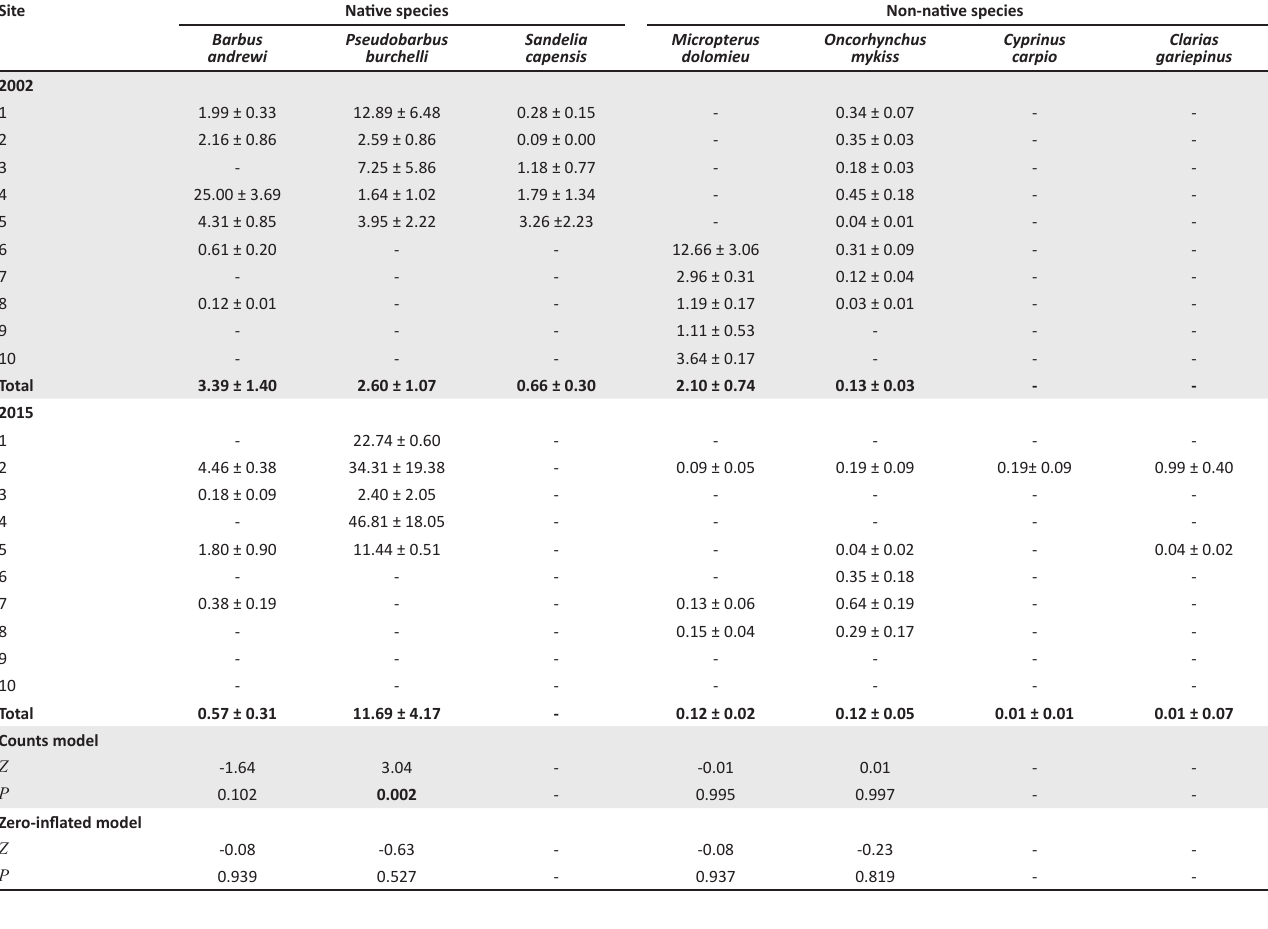
TABLE 1: Mean ± SE values for density (fish per 100 m 2 ) of fish species recorded using two-pass snorkel surveys at 10 sampling sites, and year totals, in the upper Hex River during 2002 by Christie (2002) and 2015 (the present study). Site